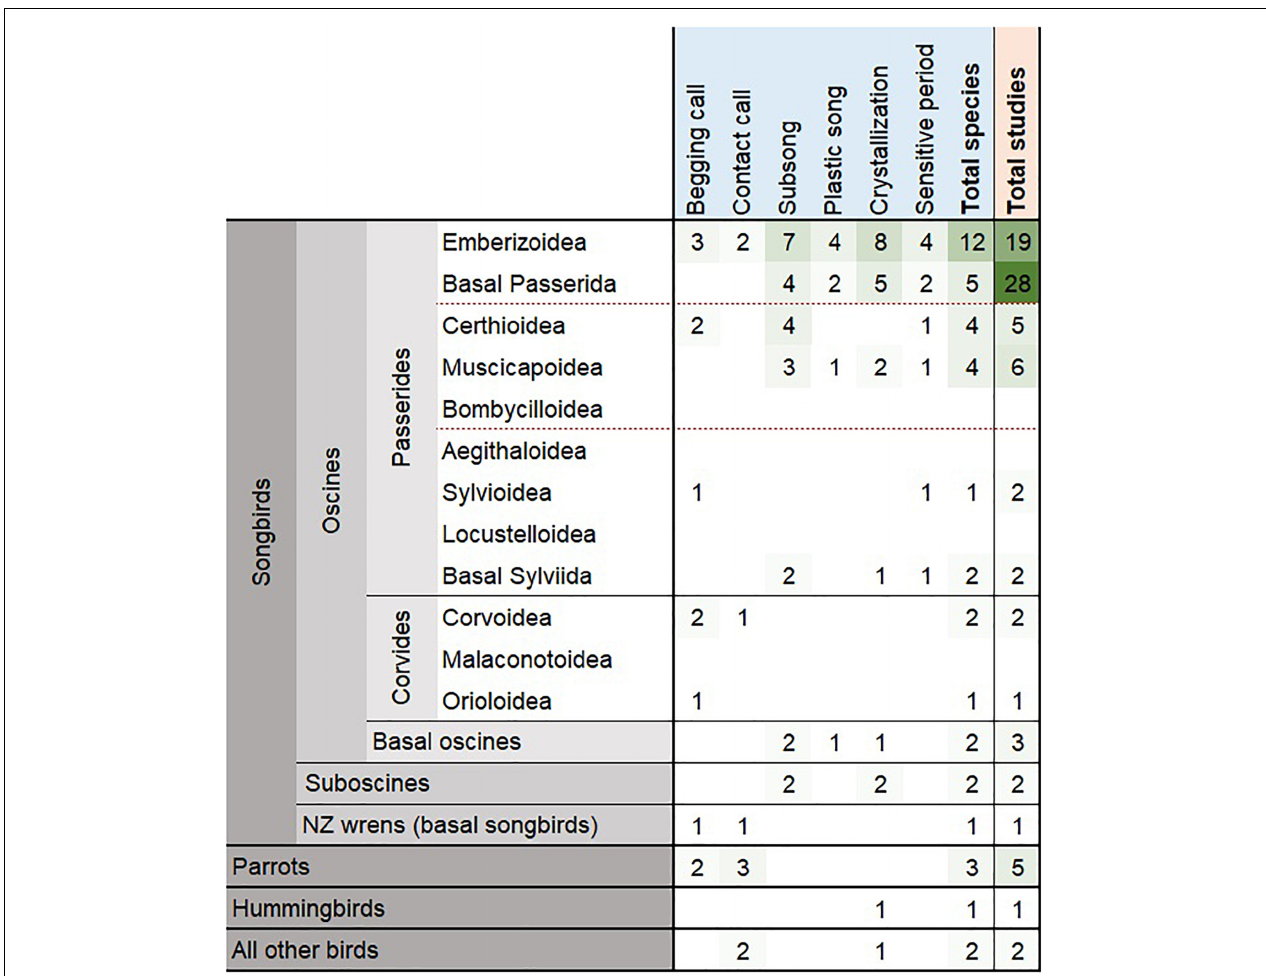
FIGURE 1 | The number of species (light blue) and number of studies (pale orange) with reported vocal development dates of birds (see Supplementary Data 1 for citations). Bird group classifications follow Oliveros et al. (2019), and are represented as dark gray for orders, medium gray for suborders, and light gray for infraorders. The oscines are represented by basal oscines, Corvides and Passerides infraorders, and red dashed lines separate parvorder groups of superfamily lineages. Parrots, hummingbirds, and all other birds are represented only in order level or higher for phylogenetic comparison to songbirds. Intensity in green shows number of species or studies in each bird